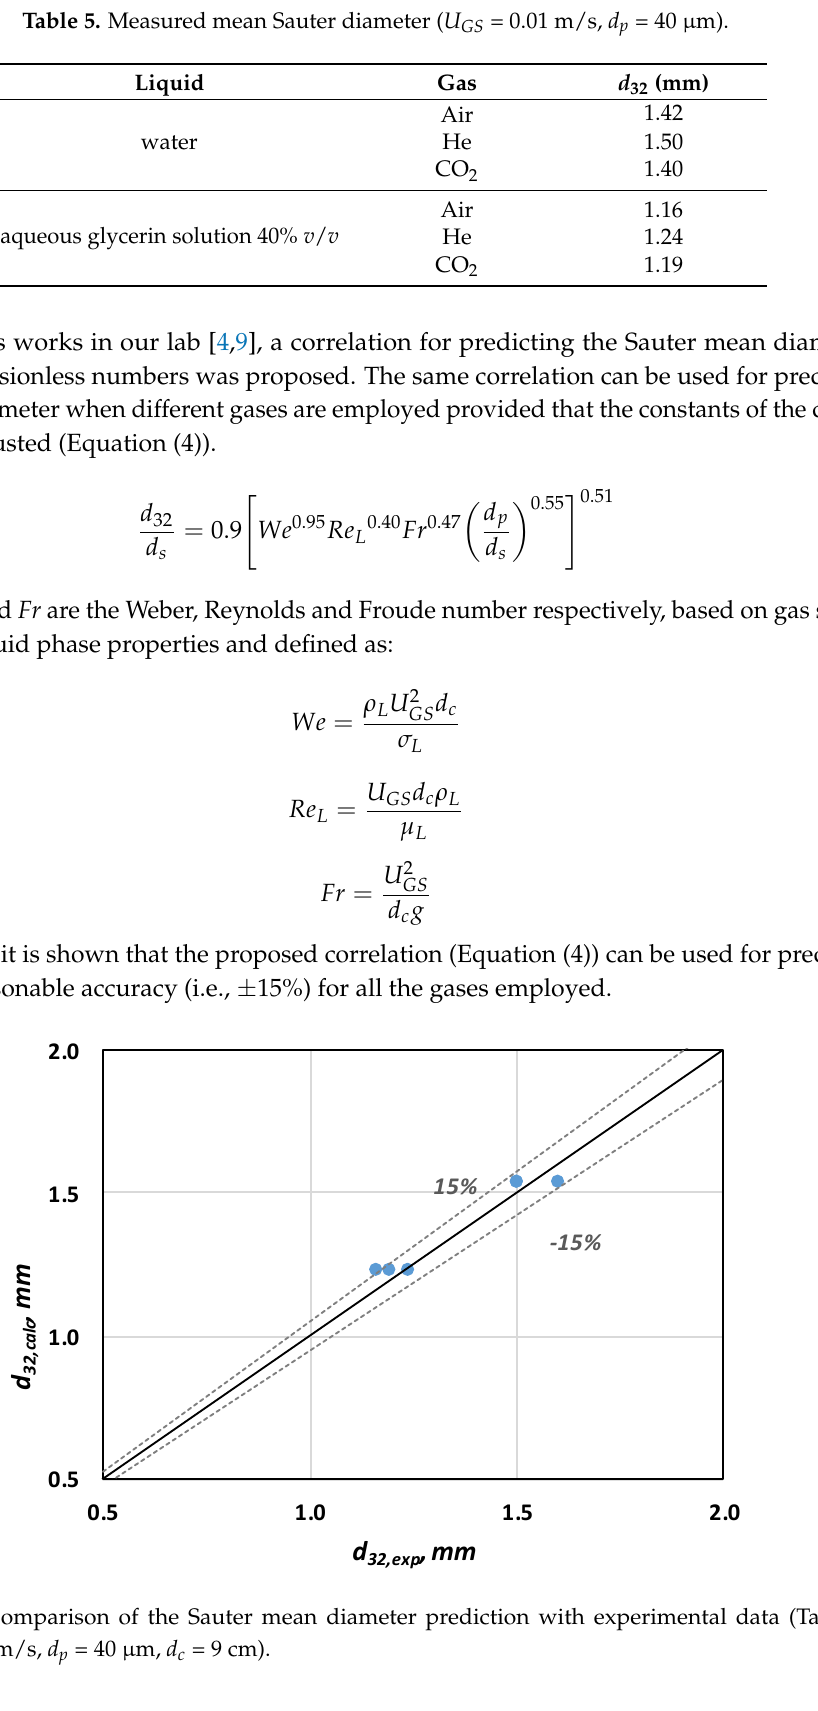
= 0.01 m/s, d p = 40 μm) . GS